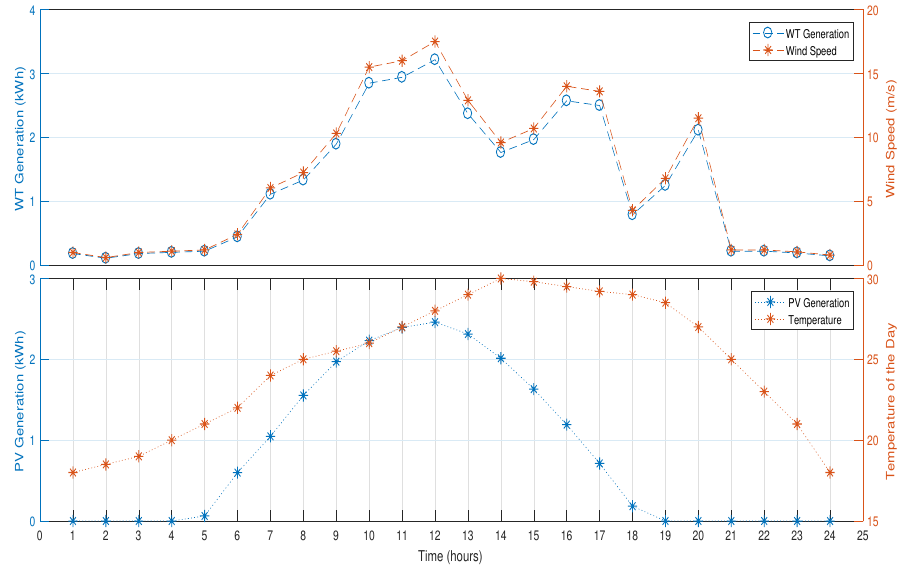
Figure 14. Relationship between wind generation and wind speed. Table 15. Effects of wind speed and temperature on wind and PV